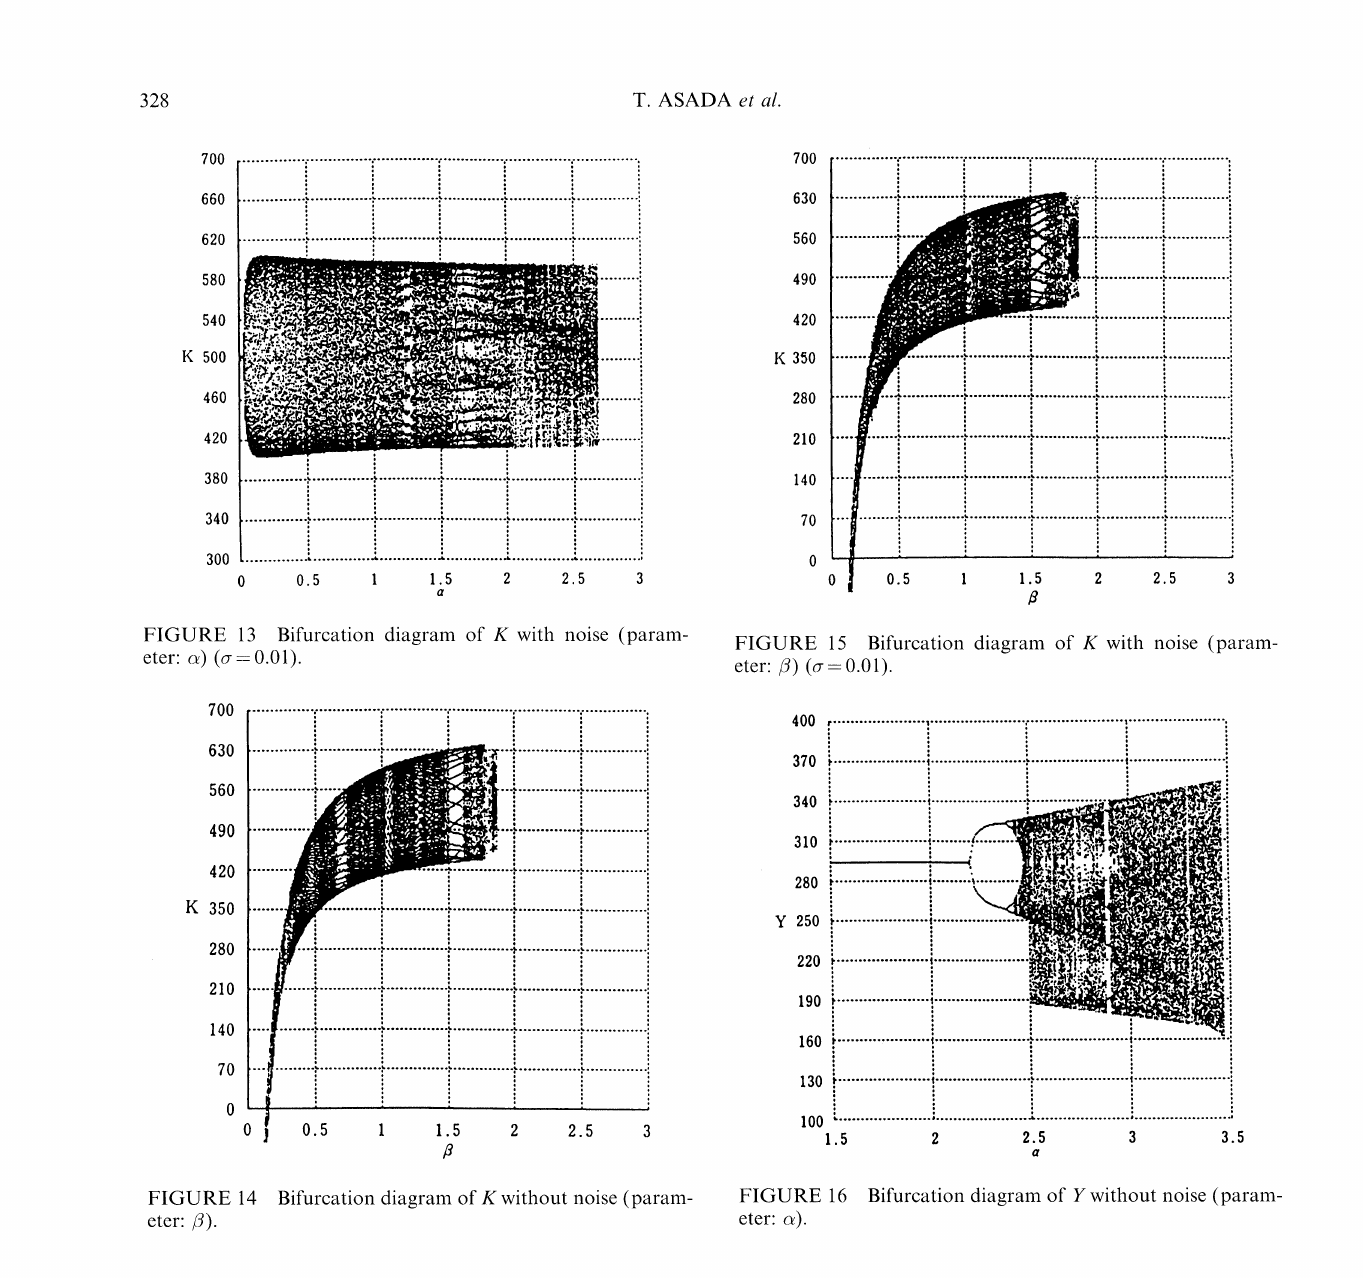
FIGURE 16 Bifurcation diagram of Y without noise (param- eter: